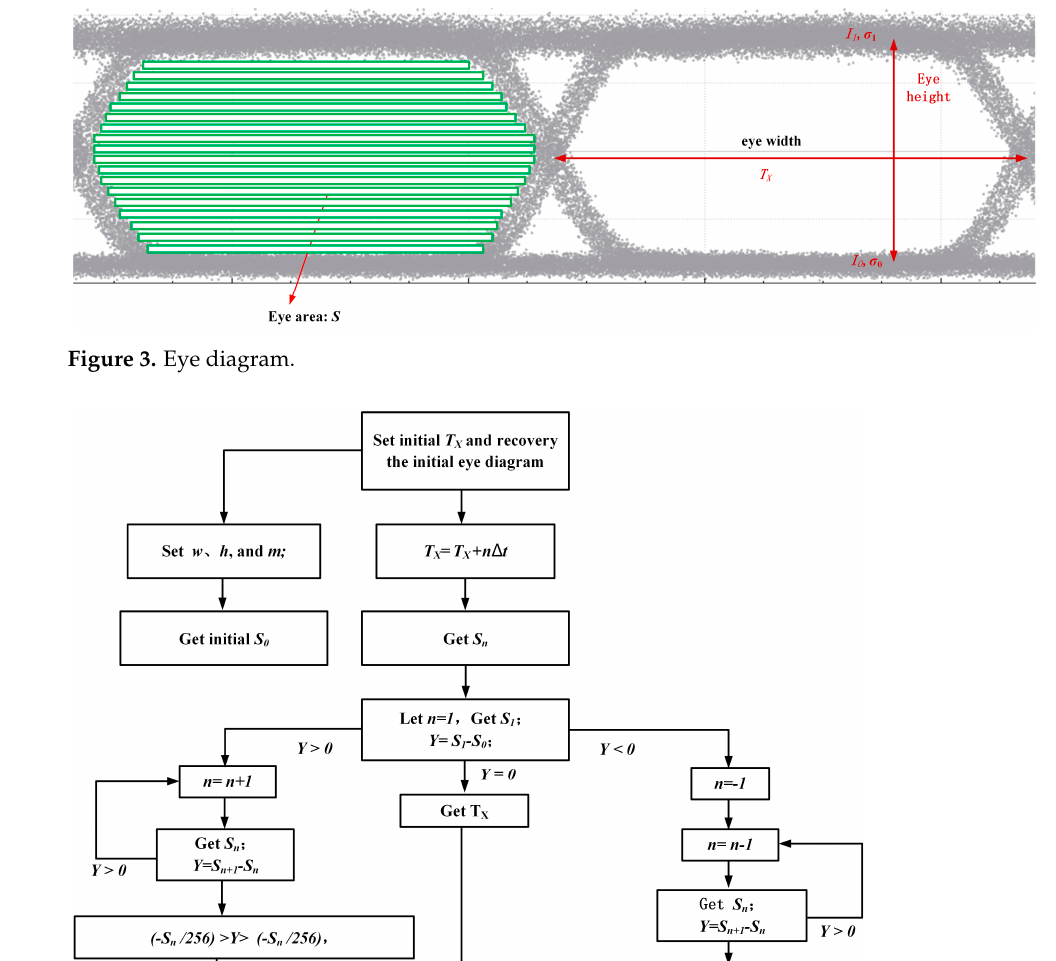
Figure 2. Principle of random equivalent sampling to recover the eye diagram. T X : the period of the optical signal under test; T S : the period of the sampling pulse; T P : pulse width of the sampling pulse.